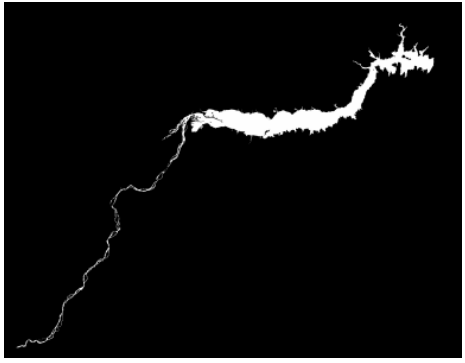
Figure 8: Reservoir detected using the image from October 2015.